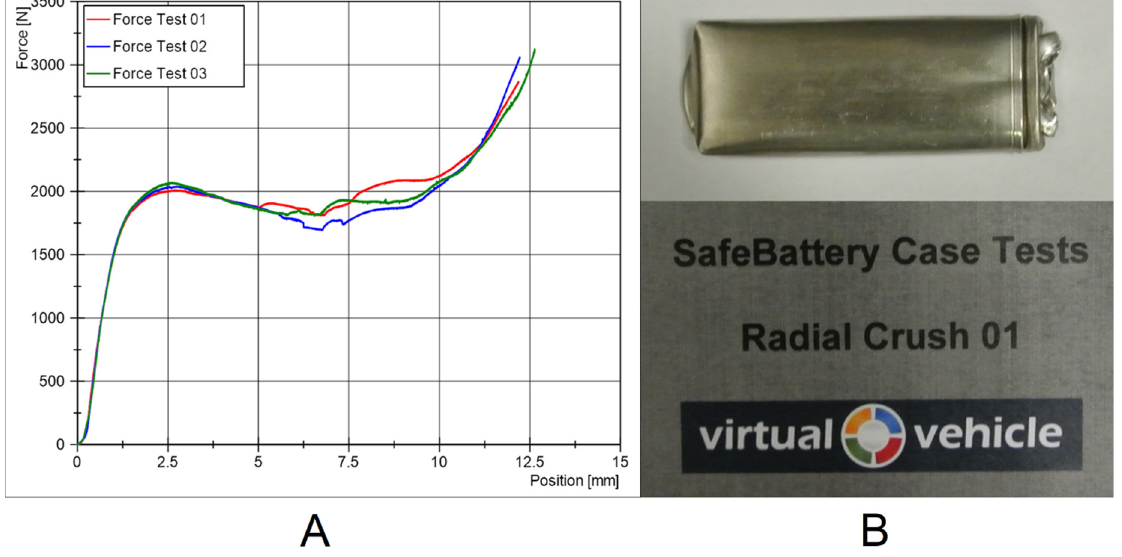
Figure A2. Results of the cell-case test for the load-case radial crush ( A ) and cell-case specimen after testing ( B ).